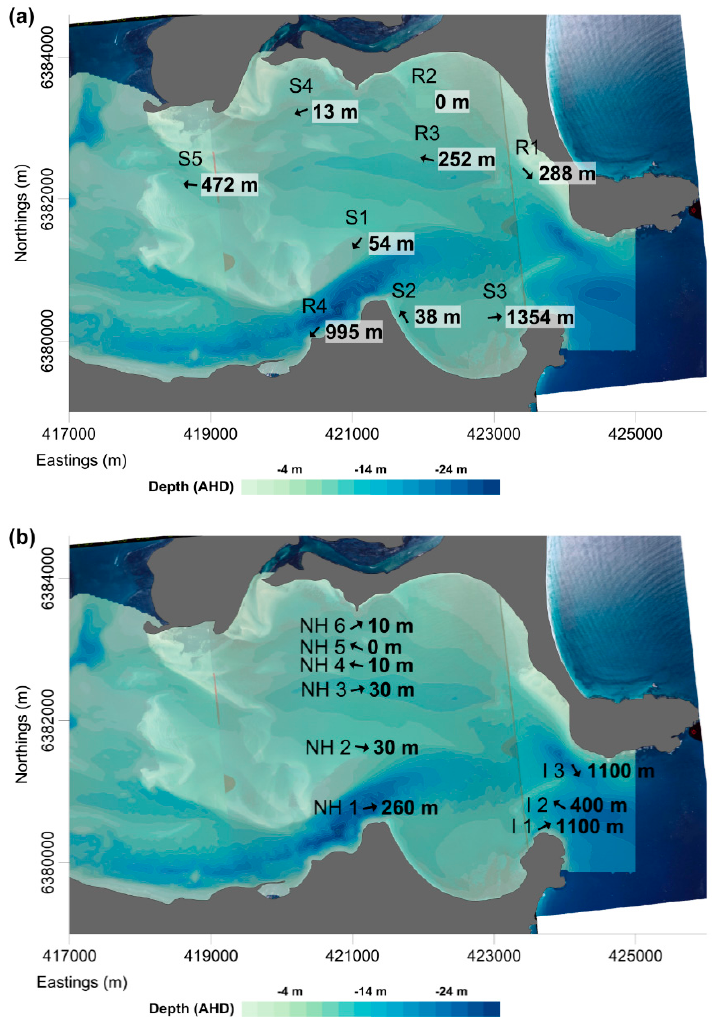
Figure 4 . ( a ) Residual distance for each of the nine bottom mounted ADCP deployments over similar spring-neap tidal cycles; and ( b ) transect residual distances with arrows representing the direction at the inlet (I) and the Nelson Head (NH) transects. Values for residual distances are given next to each arrow. Please note that entrance residual distances are a magnitude larger than the NH values. (Grid coordinates are in MGA Zone 56).